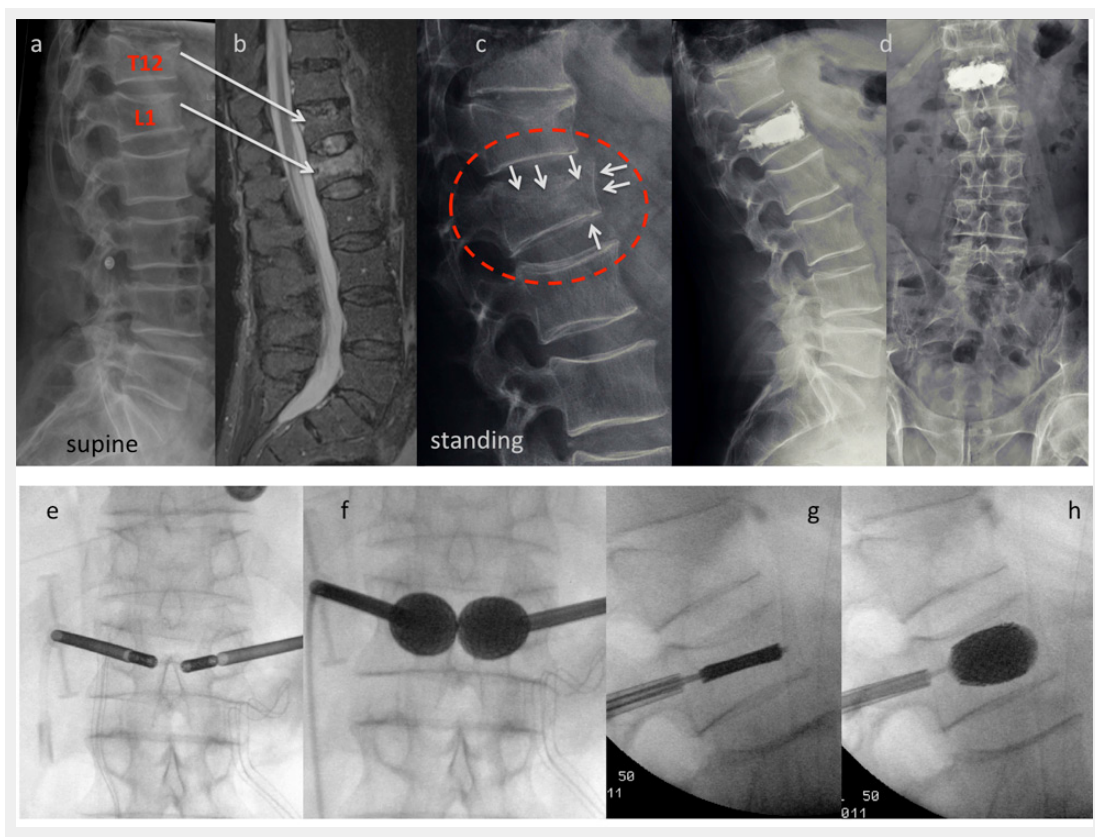
Case report stentoplasty: This 77-year-old male patient is referred to the emergency room after a fall from some 1.5 m. He presents with acute immobilising back pain. The x-ray taken in the supine position depicts fractures of T12 and L1 (a). The MRI scan discloses a fresh fracture of L1, whereas T12 appears old (b). The fracture was considered simple and conservative treatment was initiated with in- hospital physiotherapy and pain medication. After 3 days a standing X-ray was performed which shows a much more complex lesion in comparison to the initial pictures (white arrows): There is a split fracture with anterior wall displacement, and also the upper endplate has subsided considerably (c). A stentoplasty procedure was performed in local anesthesia, which did provide good height restoration and immediate stabilisation (d). The intraoperative pictures demonstrate complete restoration of the vertebral body’s shape